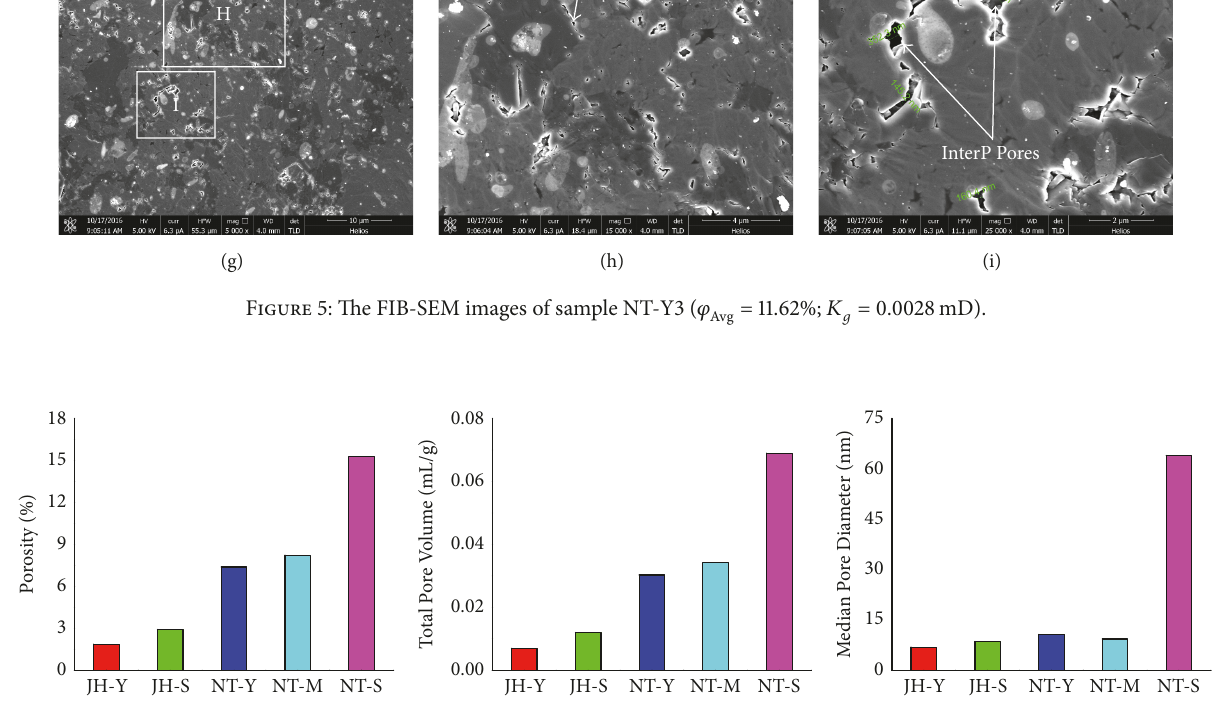
Figure 6: Comparison of MIP porosity, total pore volume, and median pore diameter averages among different lithologic groups of JH and NT coal mines (JH-Y: shale of JH; JH-S: sandstone of JH; NT-Y: shale of NT; NT-M: mudstone of NT; NT-S: sandstone of